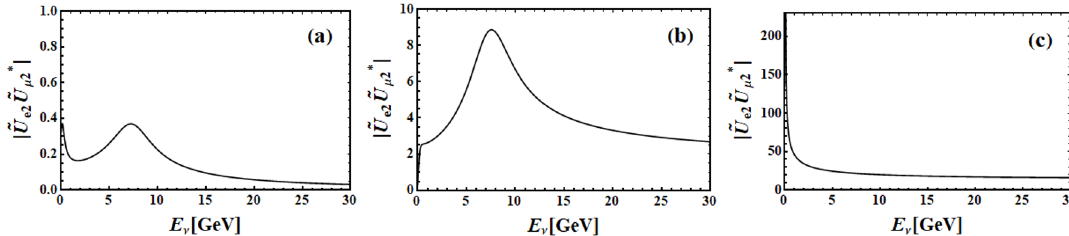
Figure 2 . Plots of (b) is from [41] and (c) is from